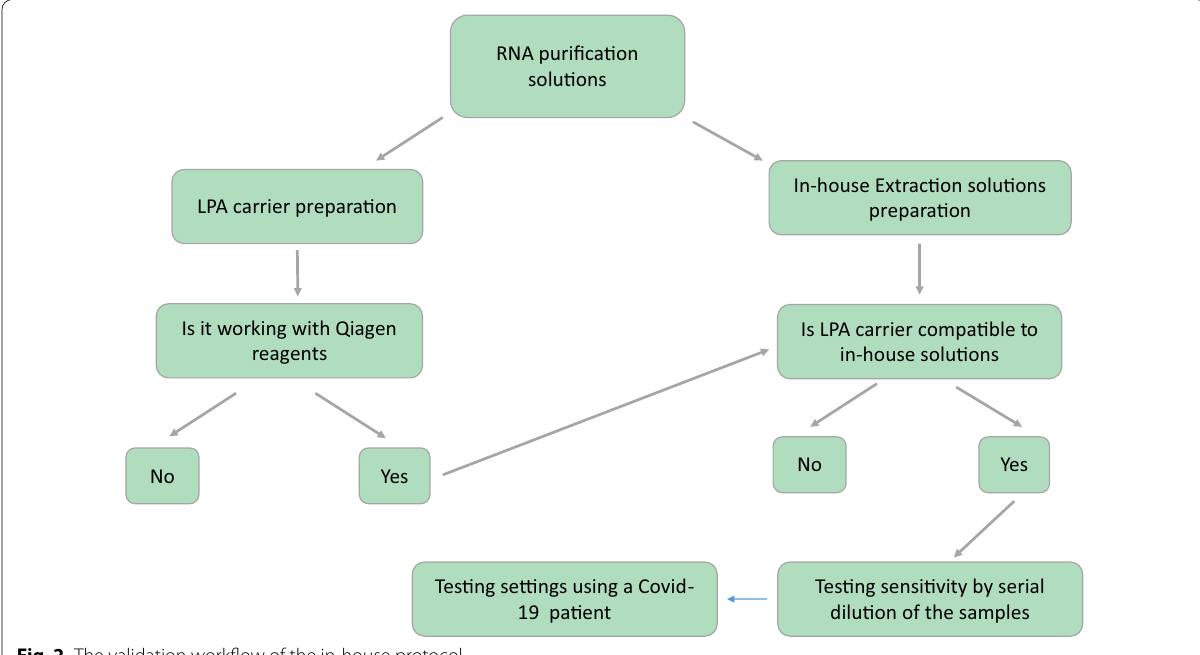
Fig. 2 The validation workflow of the in-house